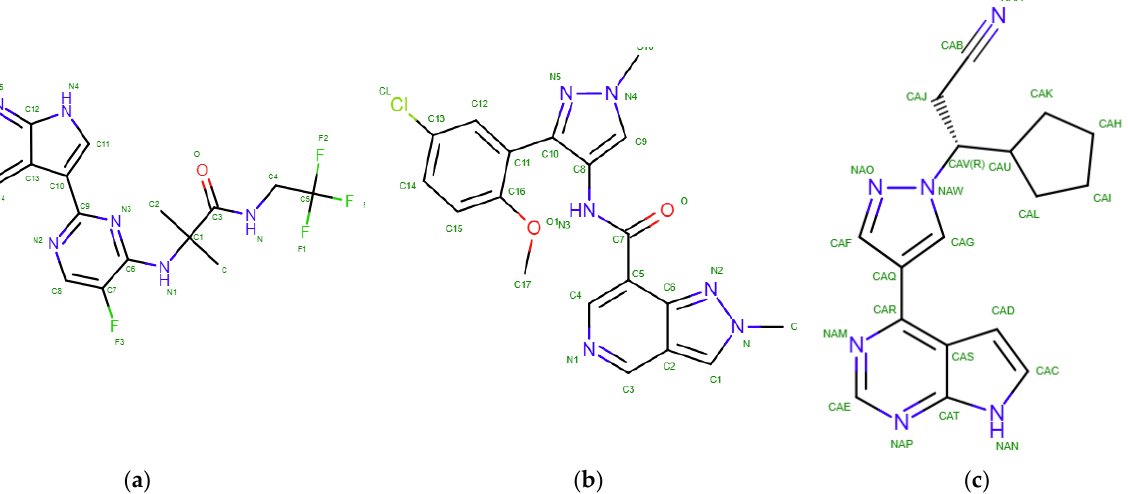
Figure 6. Structural formula of the ligand of ( a ) decernotinib (ligand-467), ( b ) KEV (ligand is drug 39 from), ( c ) ruxolitinib.